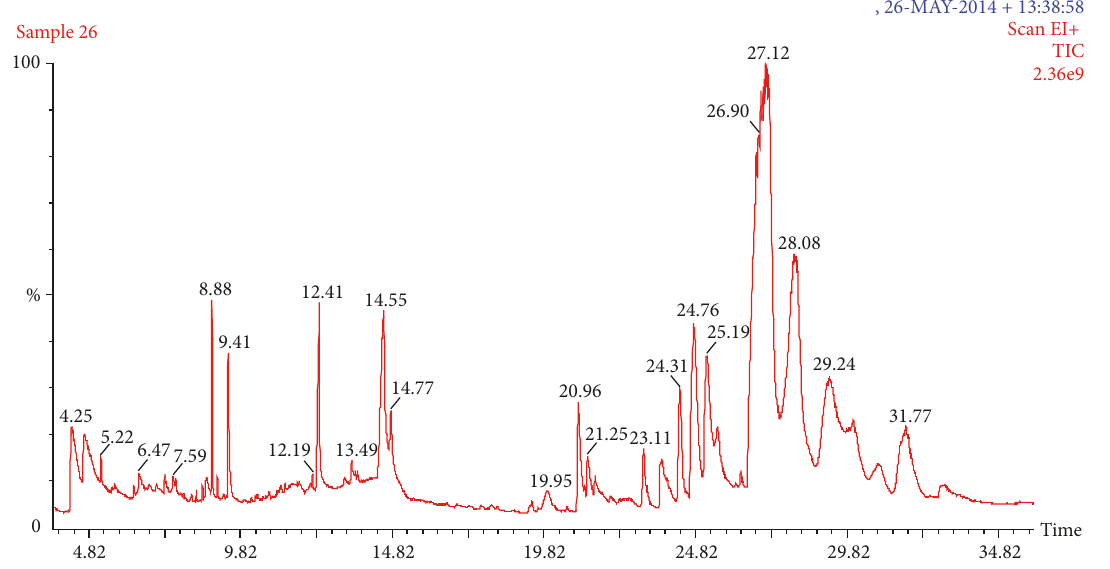
Figure 3: GC-MS chromatogram of Erythrina variegata methanol leaf